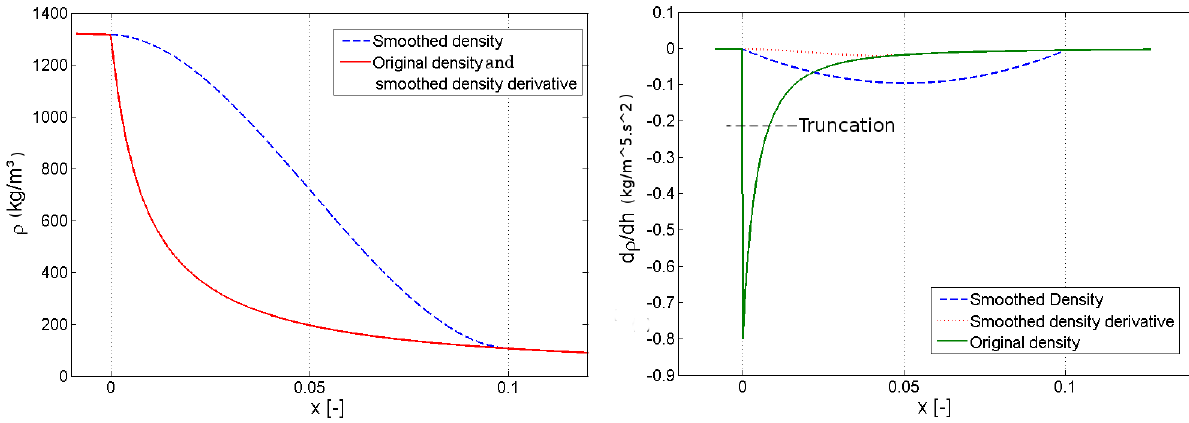
Figure 2. Original and modified density and density derivative functions vs . vapor